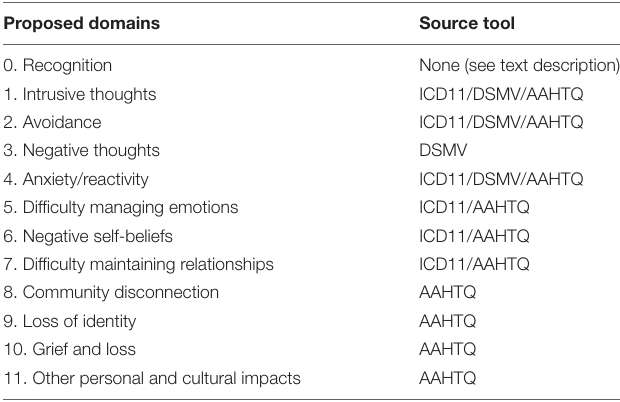
TABLE 1 | Domains proposed for inclusion in complex trauma assessment for Aboriginal parents and source tools. Proposed